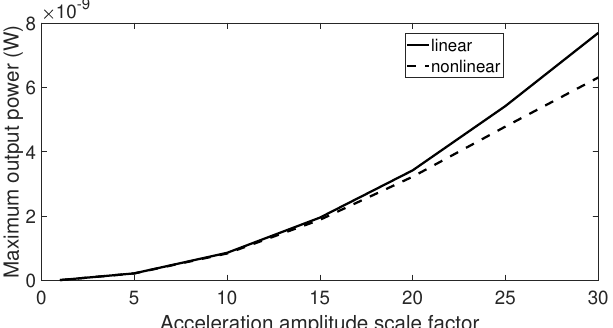
Figure 15. Maximum output power response for the linear and nonlinear prototypes under center frequency sweeping airplane passenger seat excitation when the acceleration amplitude is scaled by a factor.